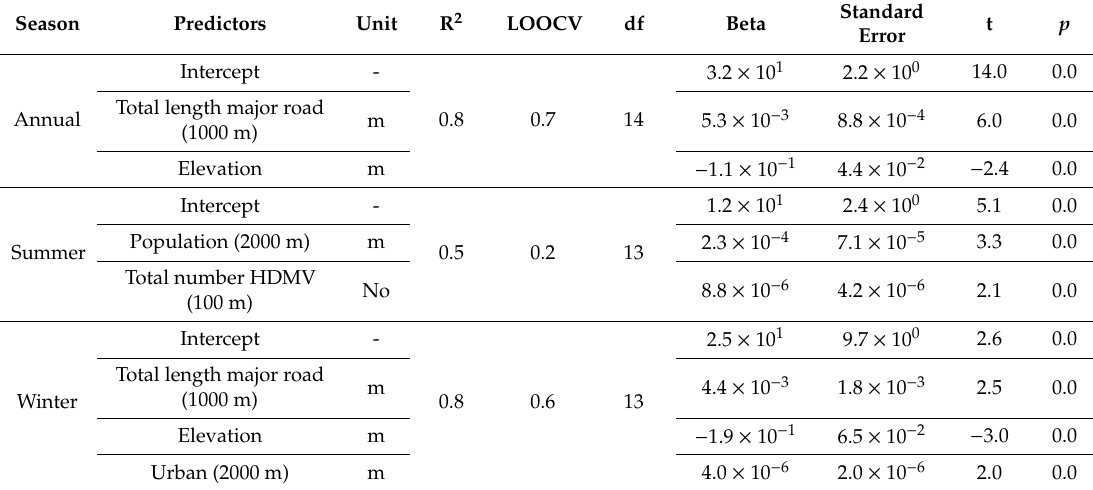
Table 4. Annual, summer, and winter PM 10 LUR model results.